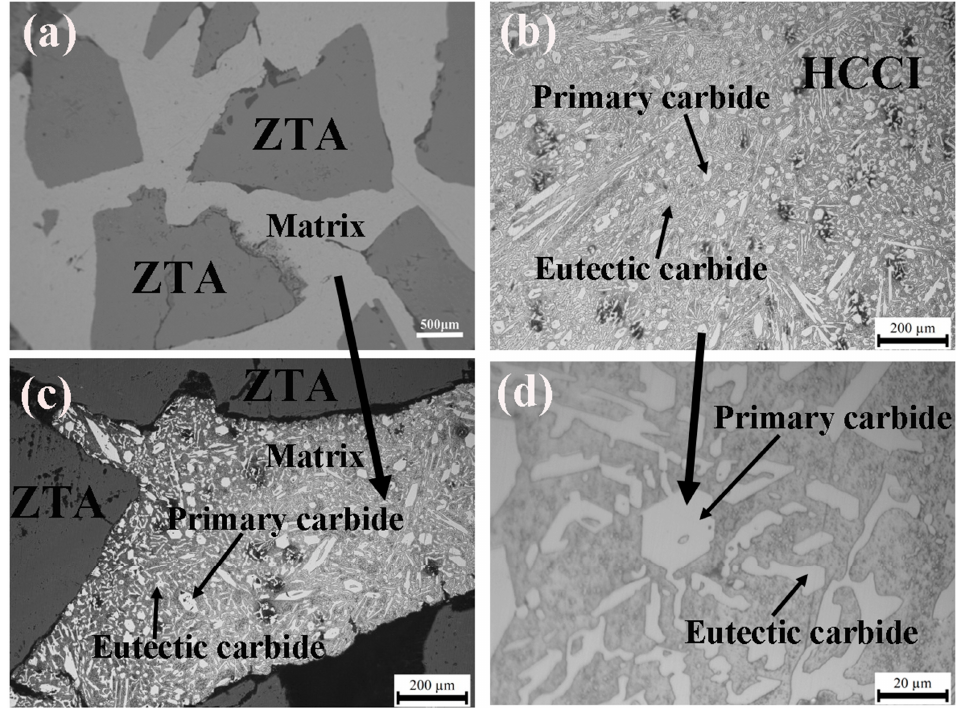
Figure 3. Metallographic microstructures of the composite and the HCCI: ( a ) Composite by SEM, ( b ) HCCI in low magnification, ( c ) Composite in low magnification, ( d ) HCCI in high magnification.